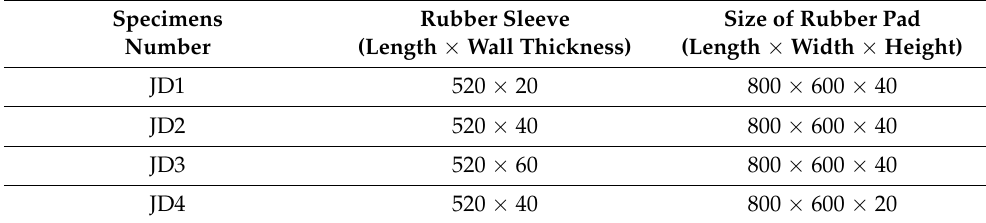
Table 1. Specimen parameters (unit: mm).